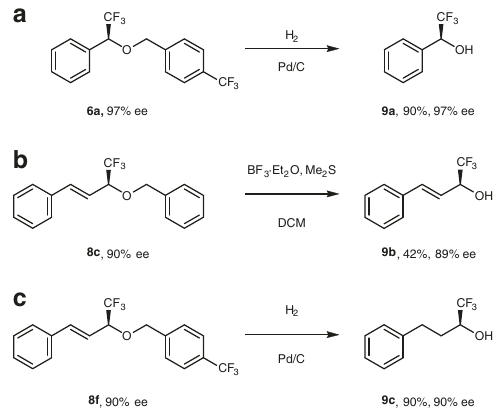
Fig. 5 Preparation of ( α -tri fl uoromethyl) aryl, vinyl, and alkyl alcohols by deprotection (or reductive deprotection) of corresponding